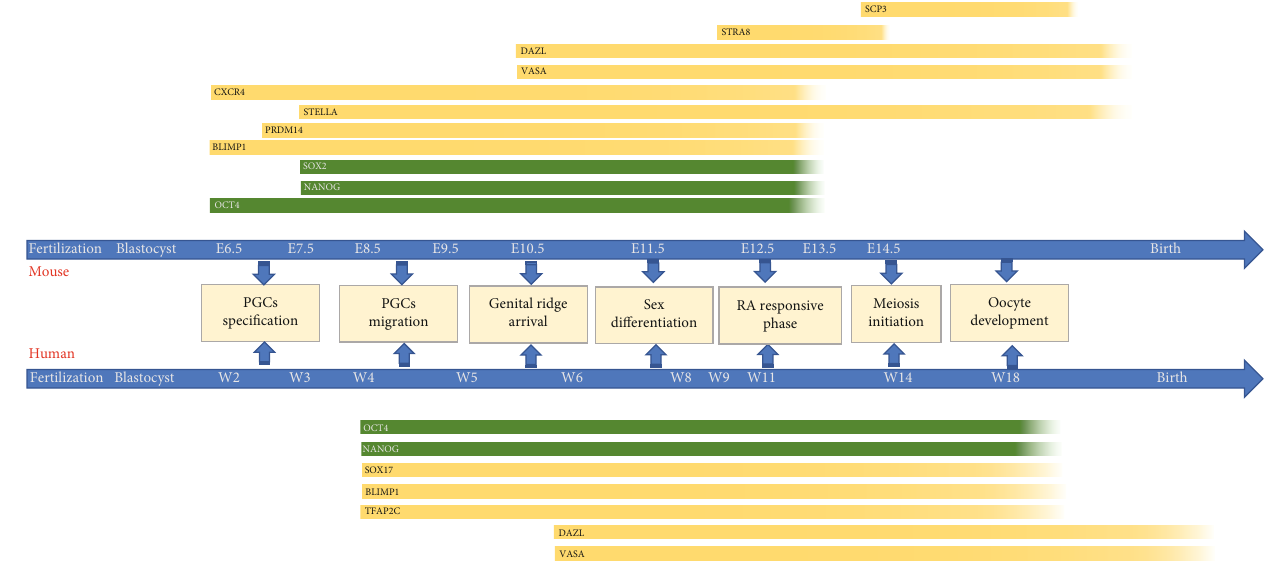
Figure 1: Schematic of female germ cell development and key gene expressions during the development. Developmental timelines and stages of mouse and human female germ cell development are shown in the center. PGCs undergo speci fi cation and migration then arrive at the genital ridge. After sex di ff erentiation, PGCs subsequently undertake RA responsive phase, meiosis initiation, and oocyte development. Key gene expressions corresponding to di ff erent developmental stages are shown in yellow bars.